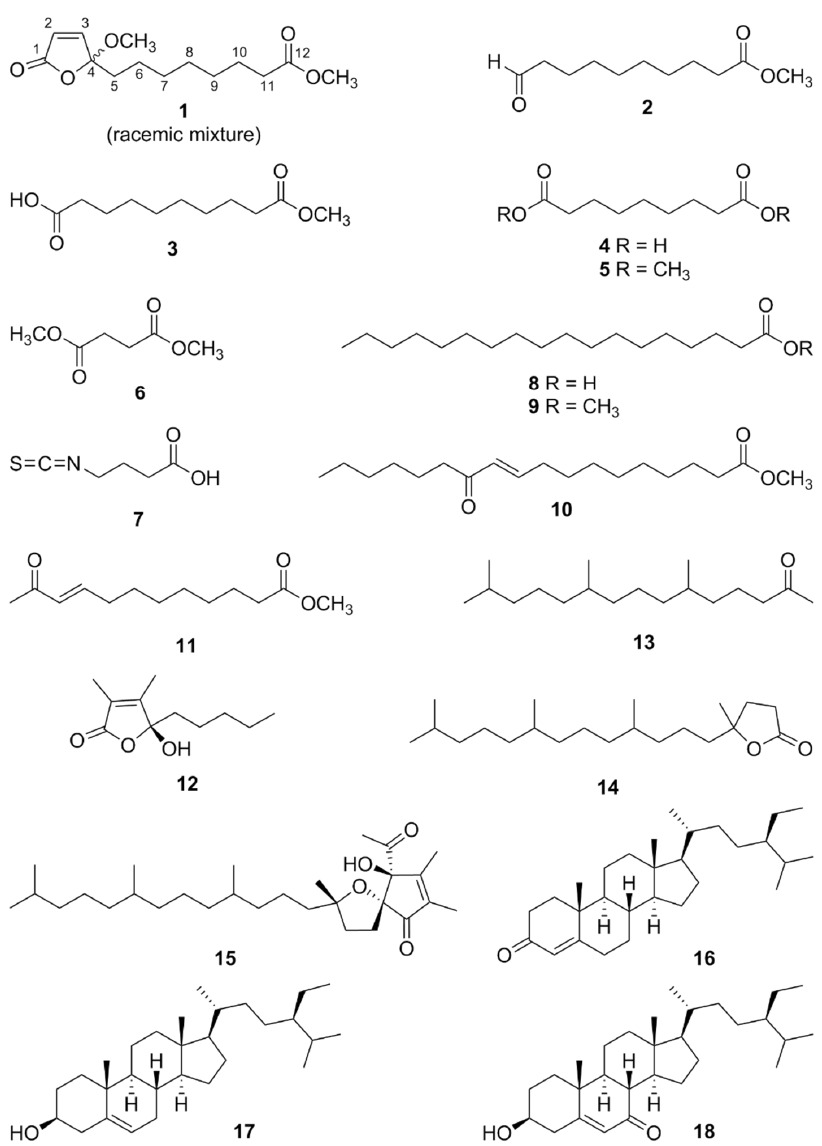
Figure 1. Chemical structure of compounds 1 – 18 .